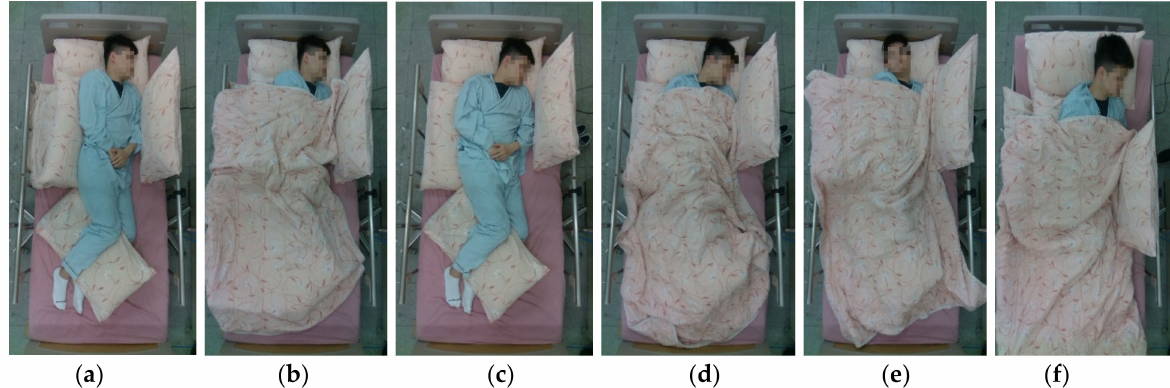
Figure 4. Some samples of left-side lying at different levels of sideward orientation; ( a ) two pillows under the right back (without covering), ( b ) two pillows under the right back (with covering), ( c ) one pillow under the right back (without covering), ( d ) one pillow under the right back (with covering), ( e ) the head orientation is not consistent with the body posture, ( f ) the bedhead is inclined at 40 degrees.